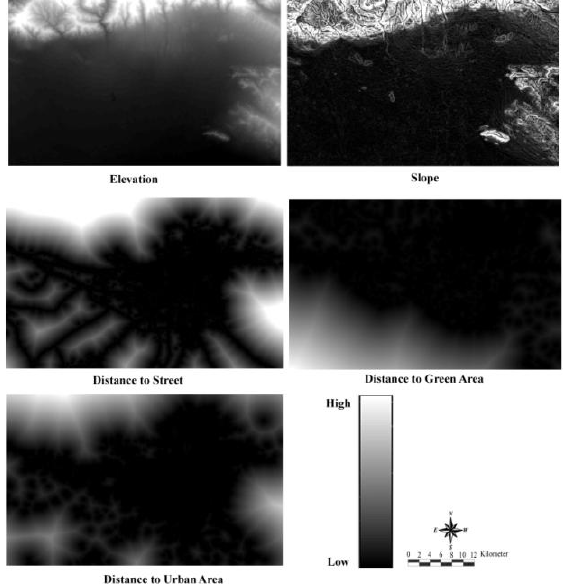
Figure 3. The normalized maps of input variables of the model f is a Mamdani fuzzy inference system which is composed of a set of rules and membership functions. This fuzzy interface system as the most commonly used fuzzy methodology is employed for the fuzzification-defuzzification process to compute the output variable, which is urban growth suitability. The fuzzification-defuzzification process is described as follows. Based on urban growth driving forces maps for each non-urban pixel, five normalized values can be extracted as inputs of model including distance to urban areas, distance to street, and distance to green areas, elevation and slope. These values are entered into their corresponding fuzzy membership functions and based on the defined fuzzy rules, the degree of membership or the fuzzy output for each non-urban pixel is calculated. The final step is to defuzzify the fuzzy output to a single crisp value representing the urban growth suitability. There are several defuzzification methods, however, the most popular one seems to be the centroid technique (Tsoukalas et al.,